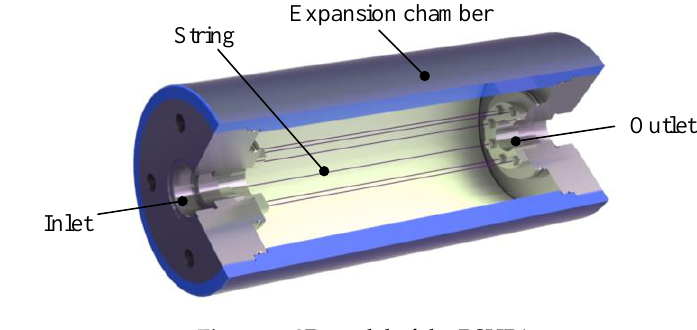
Figure 1. 3D model of the RSHPA.